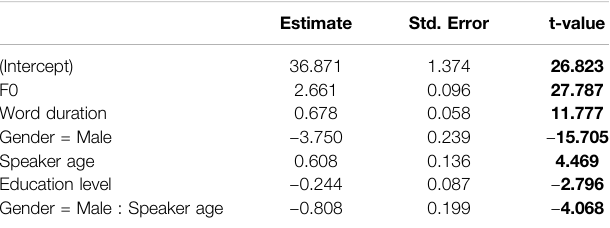
TABLE 2 | Linear mixed-effects regression summary table for HNR35. Absolute t-values larger than 2 are regarded to indicate signi fi cance and are highlighted in